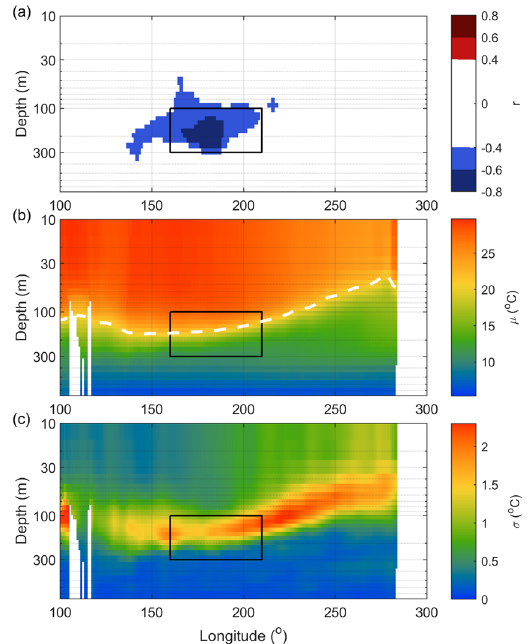
Fig. 1 Equatorial (5 ∘ S – 5 ∘ N) Paci fi c longitude-depth pro fi les. Pearson ’ s correlation coef fi cient ( r ) of May – November South China landfall counts and the preceding year ’ s June – August (JJA-1) subsurface ocean temperature anomaly in a . Correlations signi fi cant at the 99% con fi dence level using a two-tailed t-test are shaded. Climatological b mean, and c inter-annual standard deviation of JJA subsurface ocean temperature. Black box shows region selected as subNiño4 predictor index. Dotted white line is the thermocline de fi ned at 20 ∘ C.